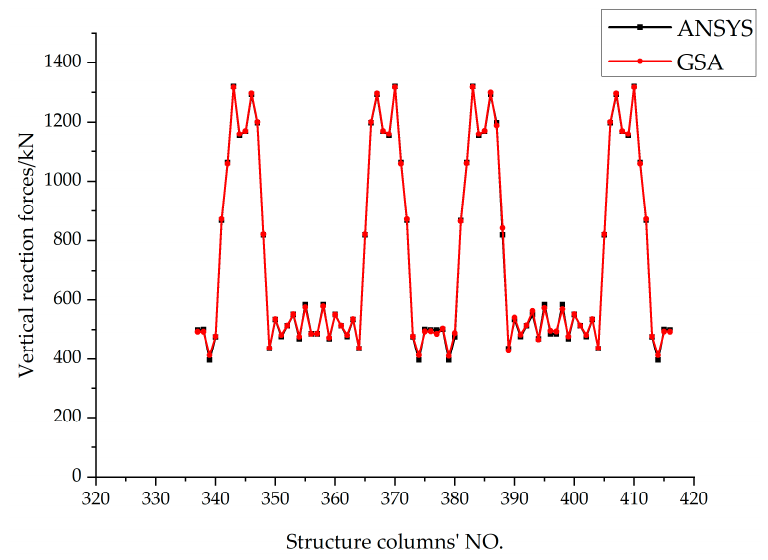
Figure 12. Comparison curve of vertical reaction forces of structural columns (kN).